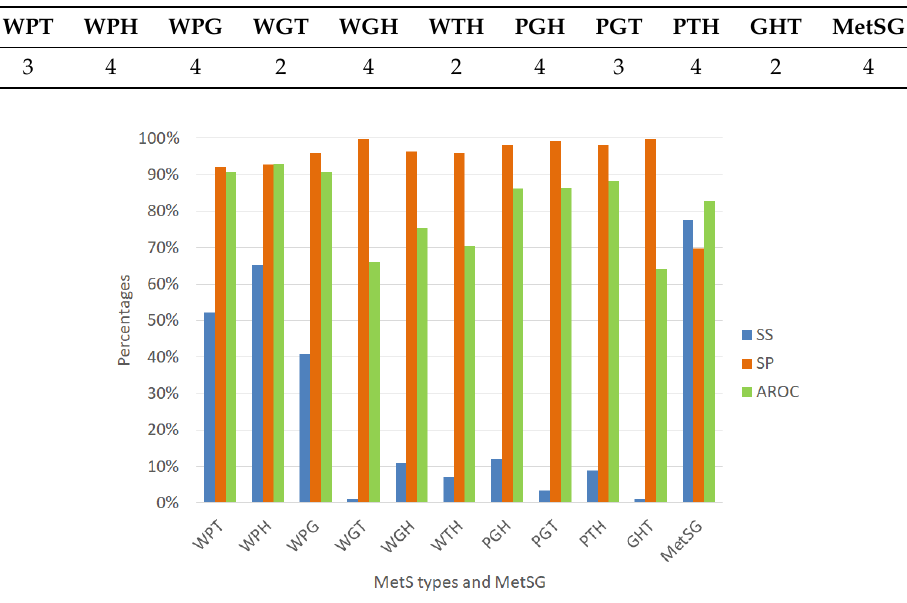
Table 13. Numbers of hidden neurons from each ANN of the MetS types.